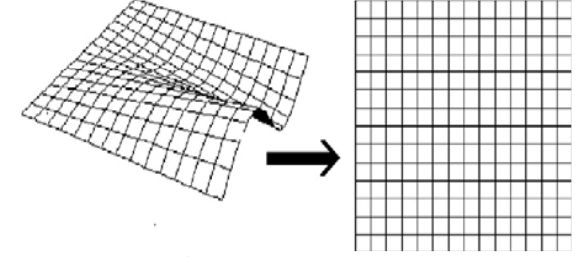
Figure 1. The forest range is presented as similar two- dimensional cells